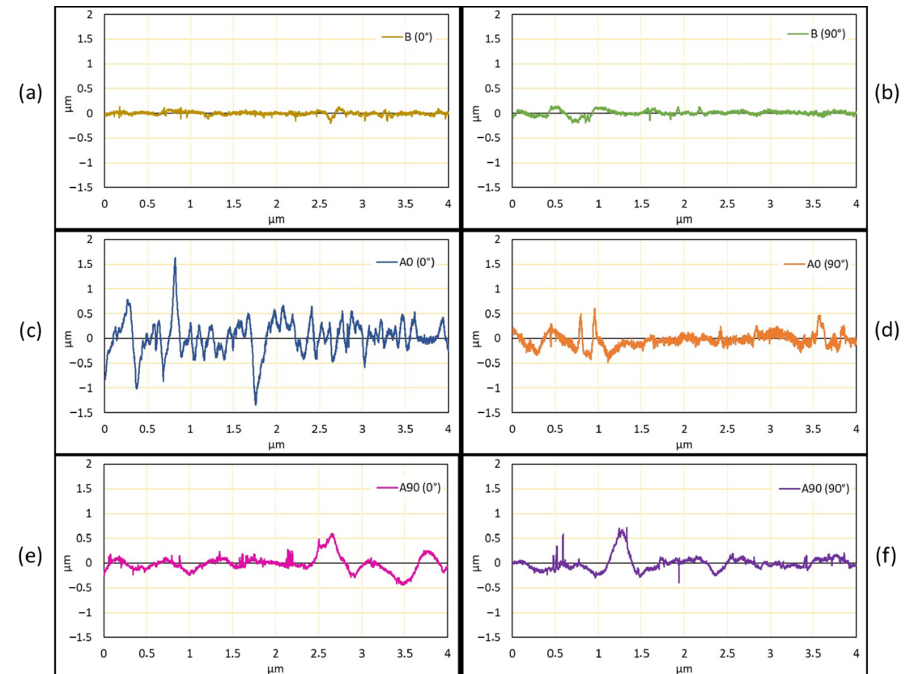
Figure 8. The surface profile of the specimen where the data were captured in the longitudinal di- rections (0°) and (90°). B is the baseline or sample before loading. A90 is the [90/0] S specimen and directions (0 ◦ ) and (90 ◦ ). B is the baseline or sample before loading. A90 is the [90/0] S specimen A0 is the [0/90] S specimen. ( a ) Surface roughness from 0° direction normal sample. ( b ) Surface and A0 is the [0/90] S specimen. ( a ) Surface roughness from 0 ◦ direction normal sample. ( b ) Surface roughness from 90° direction normal sample. ( c ) Surface roughness from 0° fiber angle of [0/90] S specimen. ( d ) Surface roughness from 90° fiber angle of [0/90] S specimen. ( e ) Surface roughness from roughness from 90 ◦ direction normal sample. ( c ) Surface roughness from 0 ◦ fiber angle of [0/90] S 0° fiber angle of [90/0] S specimen. ( f ) Surface roughness from 90° fiber angle of [90/0] S specimen. specimen. ( d ) Surface roughness from 90 ◦ fiber angle of [0/90] S specimen. ( e ) Surface roughness from 0 ◦ fiber angle of [90/0] S specimen. ( f ) Surface roughness from 90 ◦ fiber angle of [90/0] S